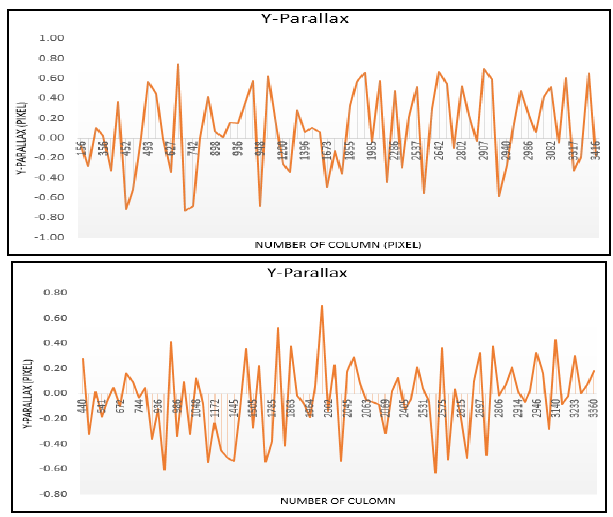
Figure 9. Y-parallax of conjugate image points on the generated epipolar images by fundamental matrix (top) and Morgan’s method (bottom) Table 2. Statistical analysis of y-parallax values Epipolar